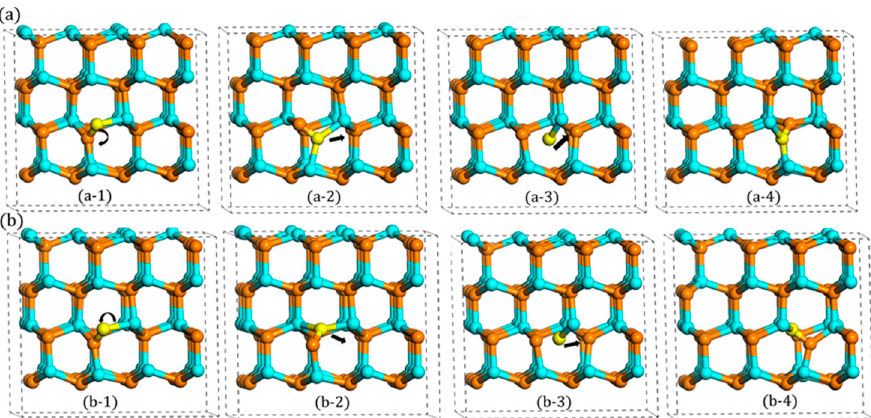
Figure 6. Two rotation-migration mechanisms to B site: ( a ) A 1 rotates to A 2 and ( b ) A 1 rotates to A 3 .